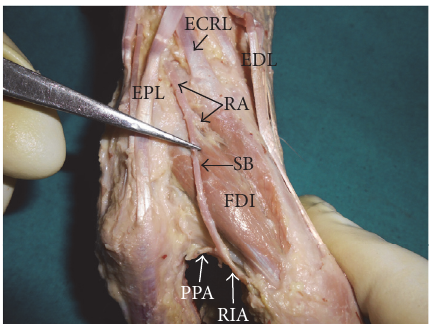
Figure 2: Dissection of dorsum of hand and wrist showing the additional tendons. (ER: extensor retinaculum; EDM: extensor dig- itorum; EPL: extensor pollicis longus; EPB: extensor pollicis brevis; TI: tendinous interconnections; ∗ : tendons of extensor digitorum; #: tendons of extensor